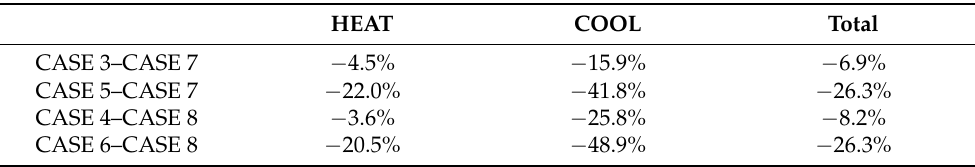
Table 8. Percentage differences in electricity consumption between different cases in heating mode (HEAT), cooling mode (COOL) and annual demand.